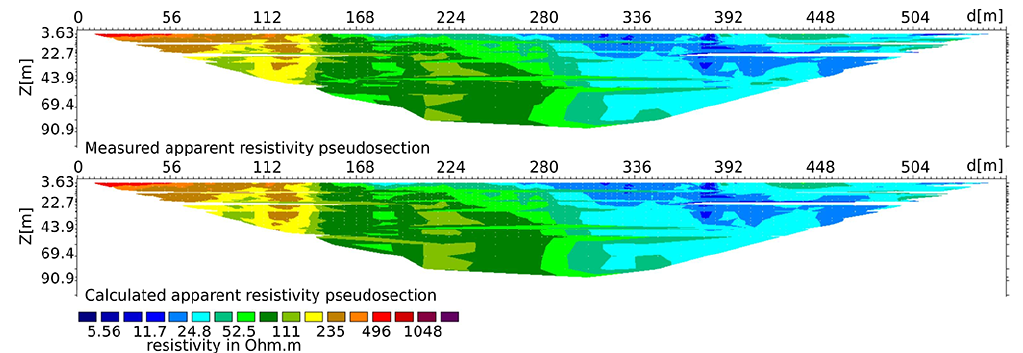
Figure A3. Apparent resistivity pseudosections. Measured (top) and obtained from inversion (bottom) apparent resistivity pseudosections along L2 profile.